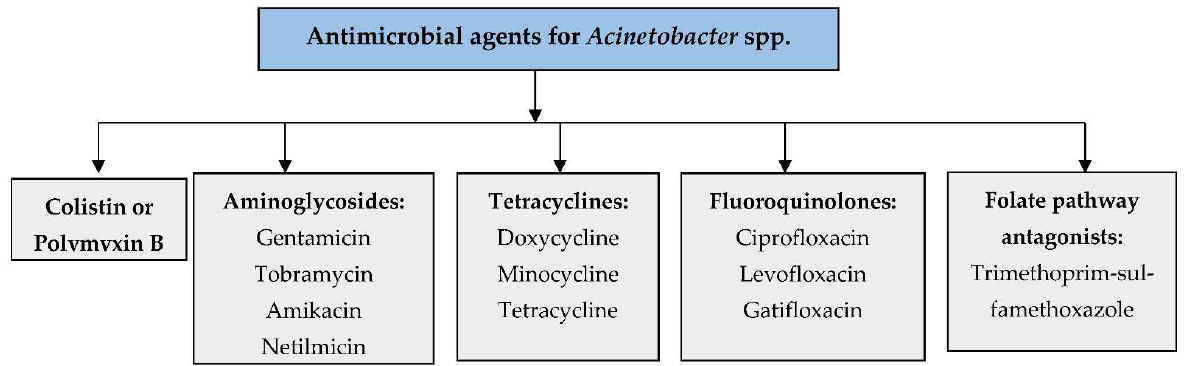
Figure 2. Antimicrobial agents used for Acinetobacter spp. infections.